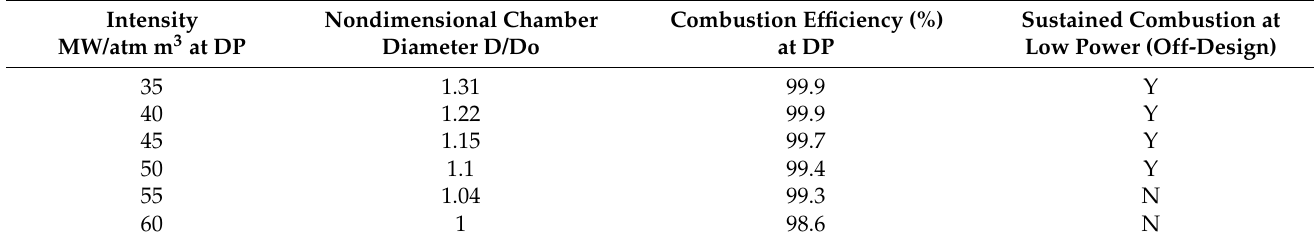
Table 4. Combustion efficiency and stability evaluation for various intensity factors.